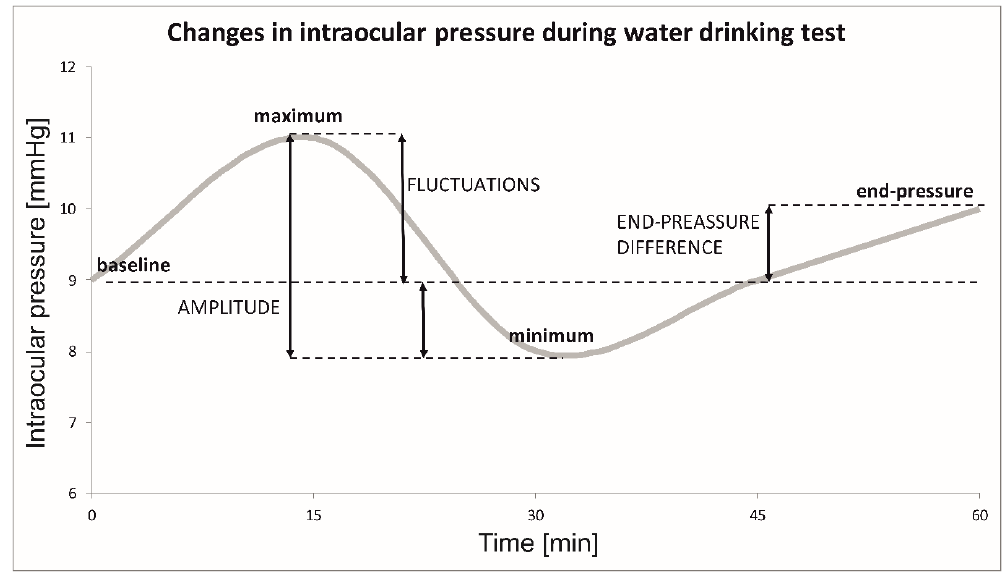
Figure 1. Changes in the intraocular pressure during the water drinking test.